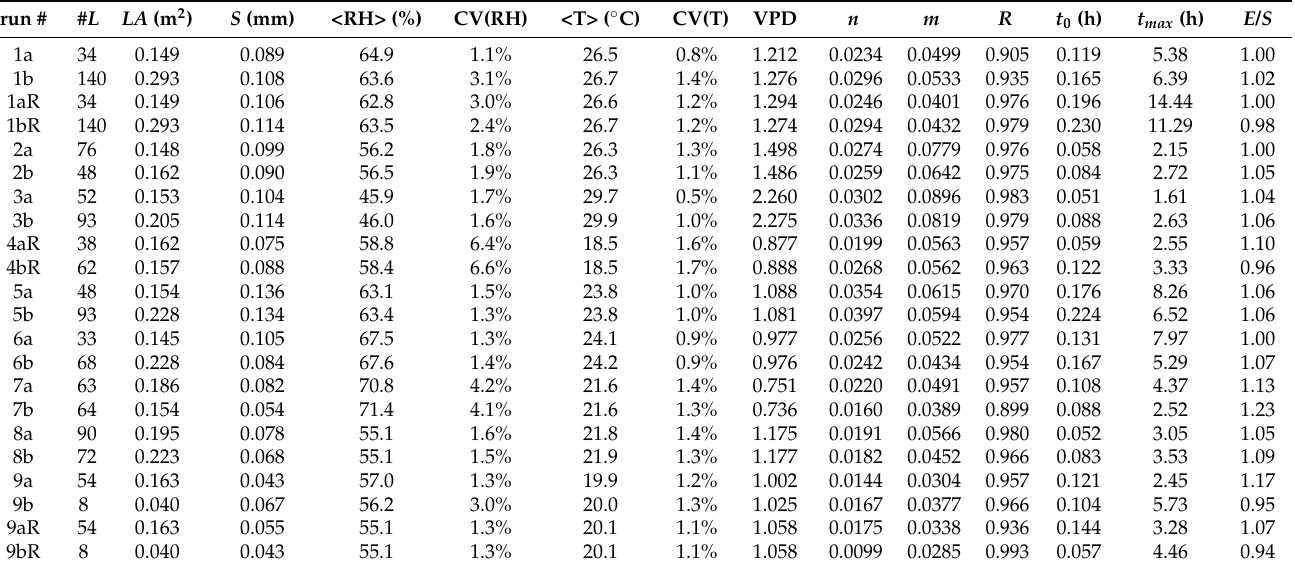
Table 1. For the 22 runs, number of leaves, # L , leaf area, LA , interception capacity, S , mean relative humidity and temperature, <RH> and <T>, with the corresponding coefficient of variation, CV, vapour pressure deficit, VPD, n and m parameters, correlation coefficient, characteristic times, t 0 and t max , and the ratio E / S